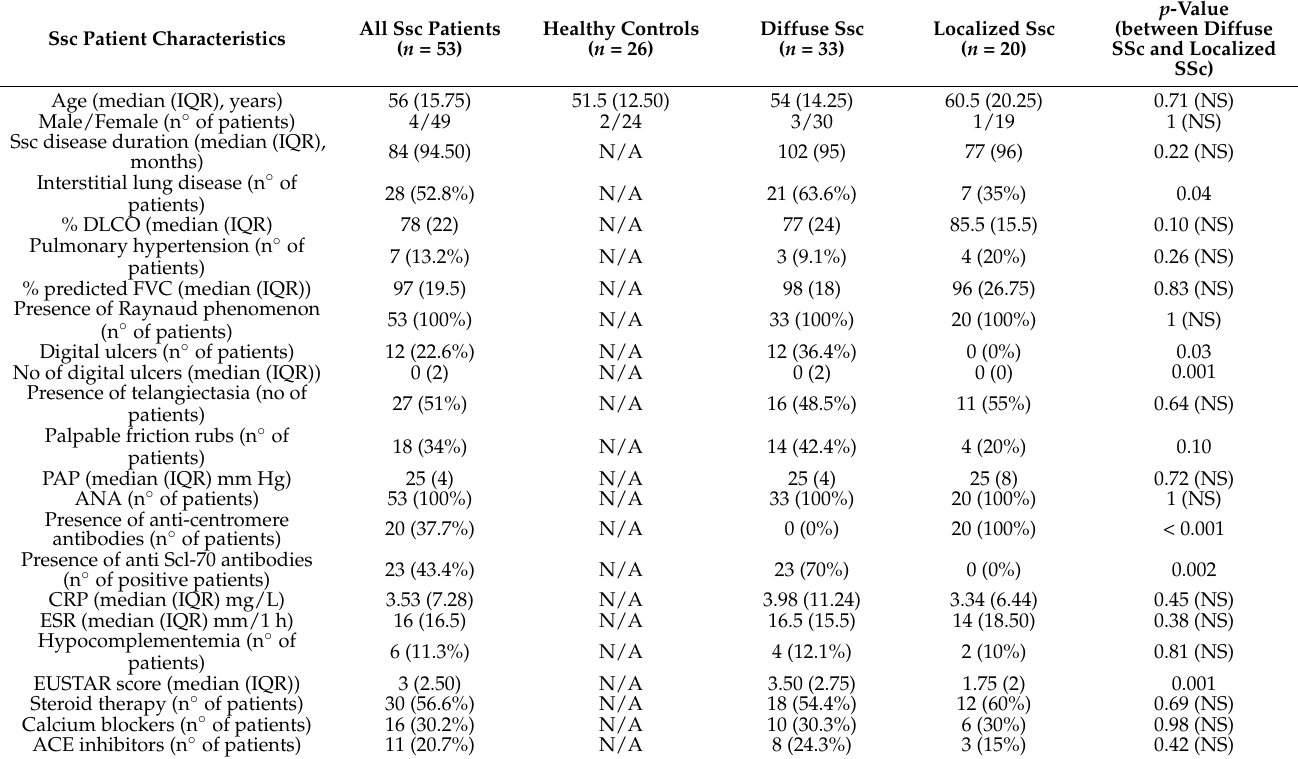
Table 1. Characteristics of included Ssc patients and healthy